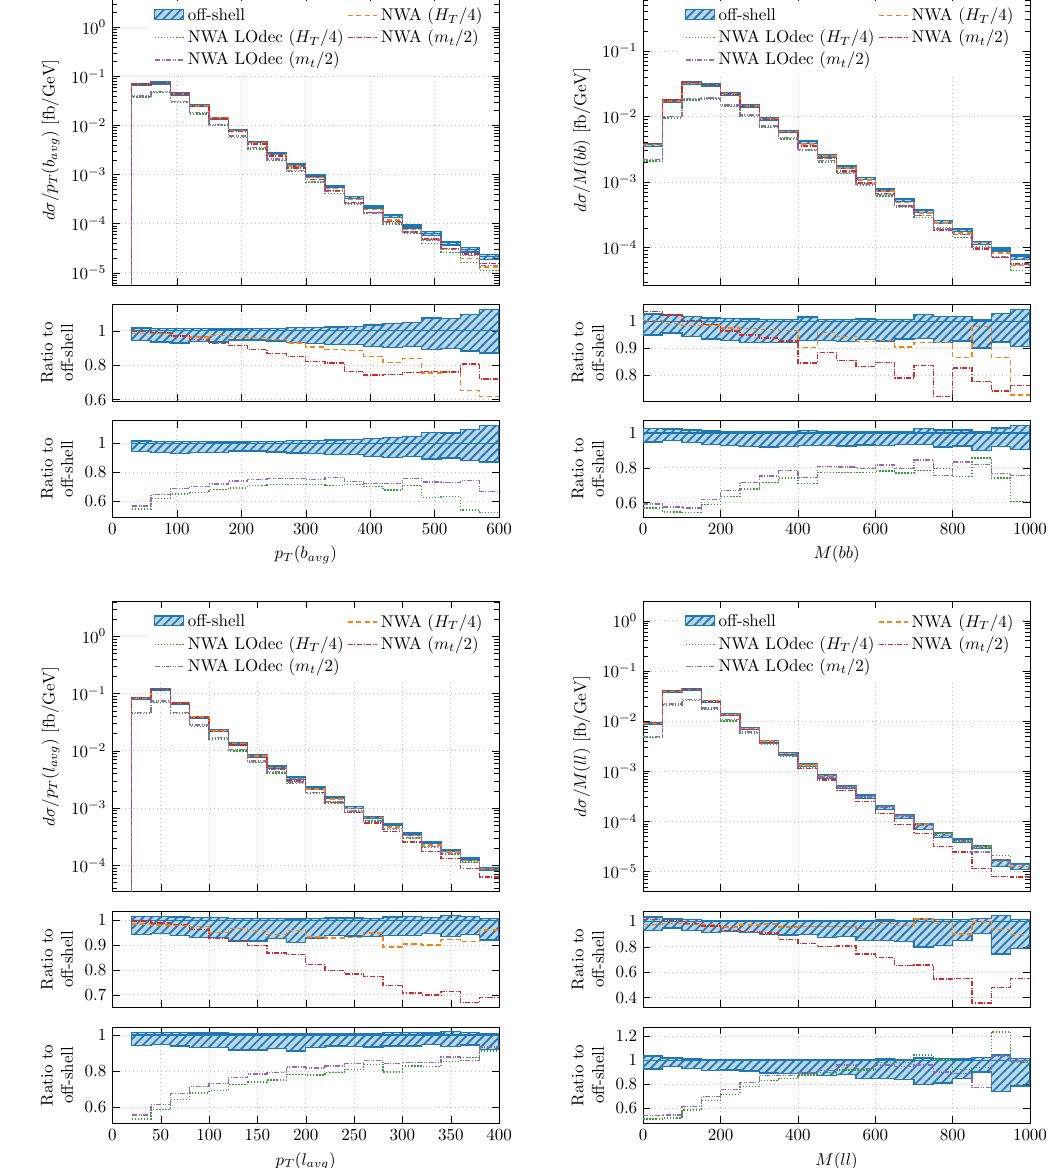
Figure 5 . Di(cid:11)erential cross section distribution as a function of the (averaged) transverse momen- tum of the b -jet, p T ( b avg ), and charged lepton, p T ( ‘ avg ), as well as the invariant mass of the two b -jets, M ( bb ), and two charged leptons system, M ( ‘‘ ), for the pp LHC run II with p s = 13 TeV. The CT14 PDF set is employed.